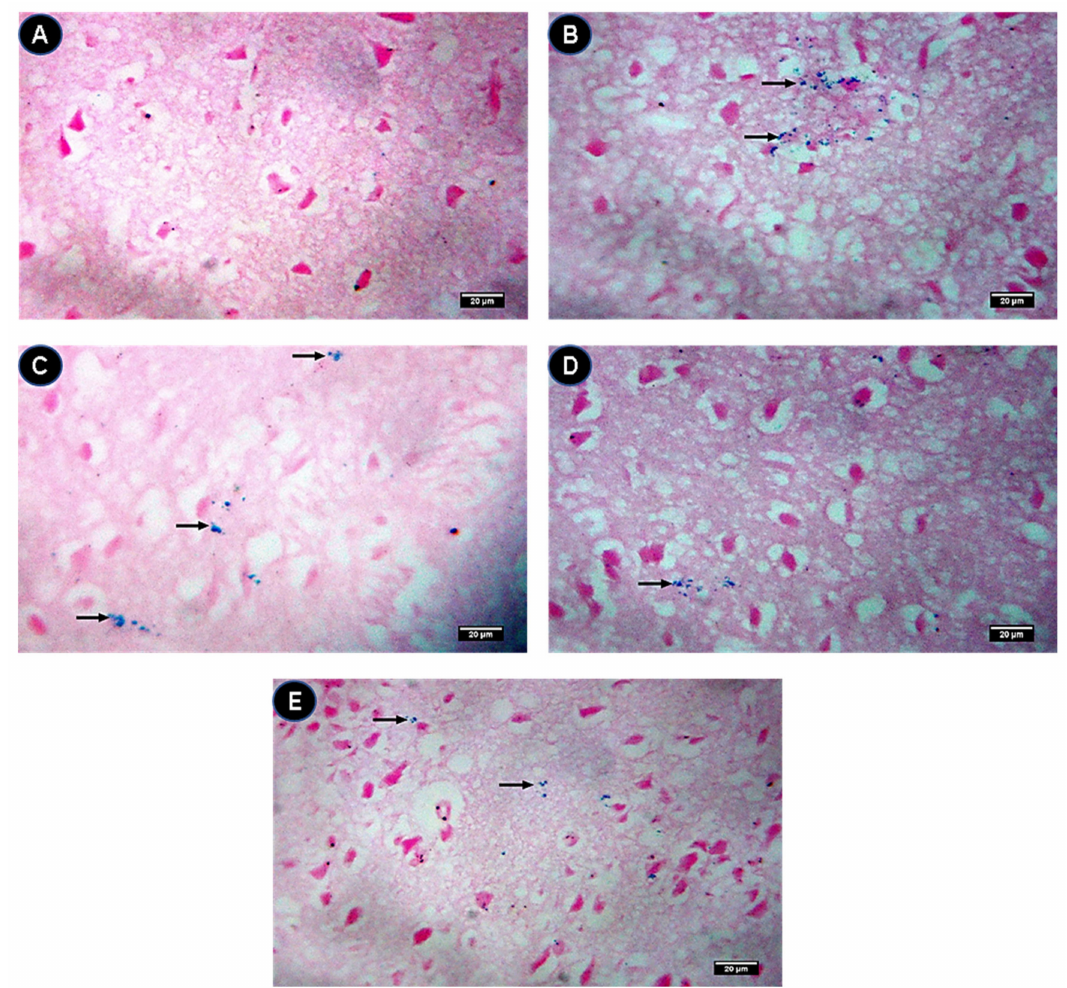
Figure 7. Brain tissue stained with Prussian blue (Black arrows). ( A ) Control group showing a negative Prussian blue stain. ( B ) IONPs group showing blue spots representing the iron contents by Prussian blue stain. ( C ) IONPs + Q25 group showing moderate blue spots representing the iron contents by Prussian blue stain. ( D ) IONPs + Q50 group showing a few blue spots representing the iron contents by Prussian blue stain. ( E ) IONPs + Q100 group showing very few dispersed blue spots representing the iron contents by Prussian blue stain. × 400. Scale bar = 20 µ